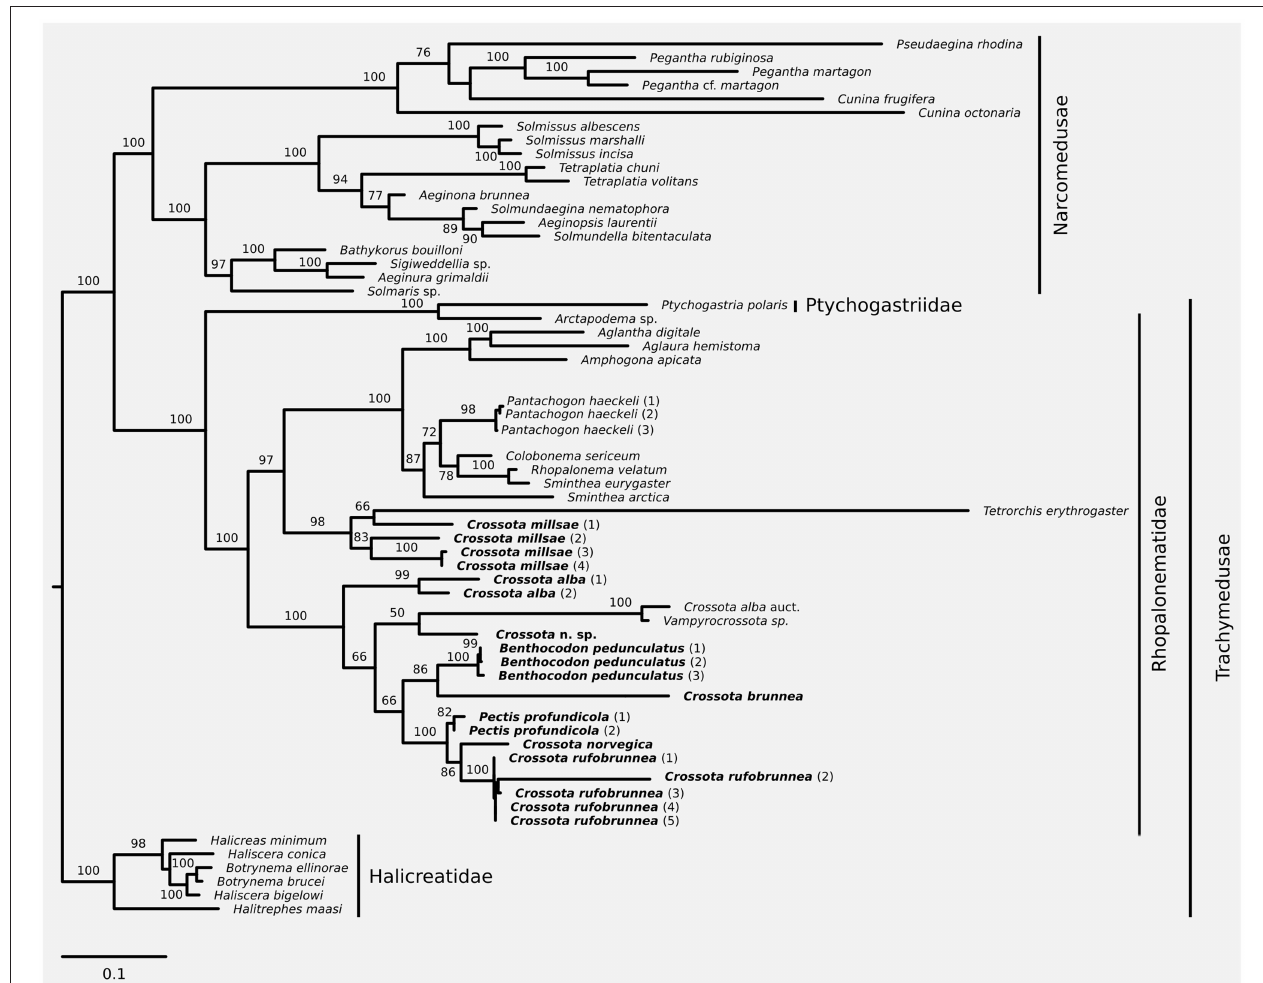
FIGURE 1 | Maximum likelihood phylogeny based on a combined dataset of nuclear 18S and 28S plus mitochondrial 16S and COI. Taxa discussed in this contribution in bold font. Node support was inferred using 1,000 non-parametric bootstrap replicates. Substitution model for phylogenetic reconstruction and bootstrapping was GTR + I + G; scale bar represents substitutions per